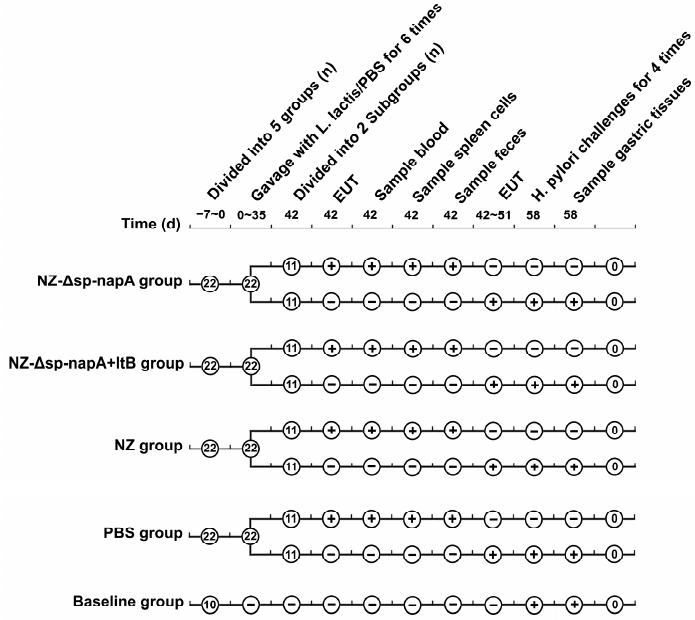
Figure 1. Experimental management of the BALB/c mice. +: received the treatment; − : was not given the treatment; EUT: euthanasia.